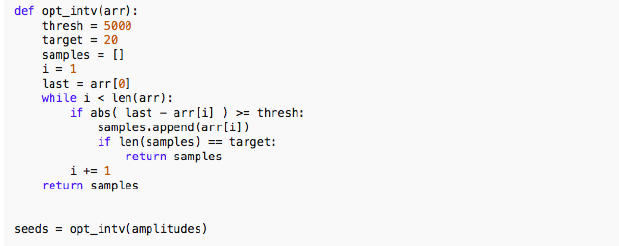
Fig. 7. Sample snippet for the algorithm optimisation